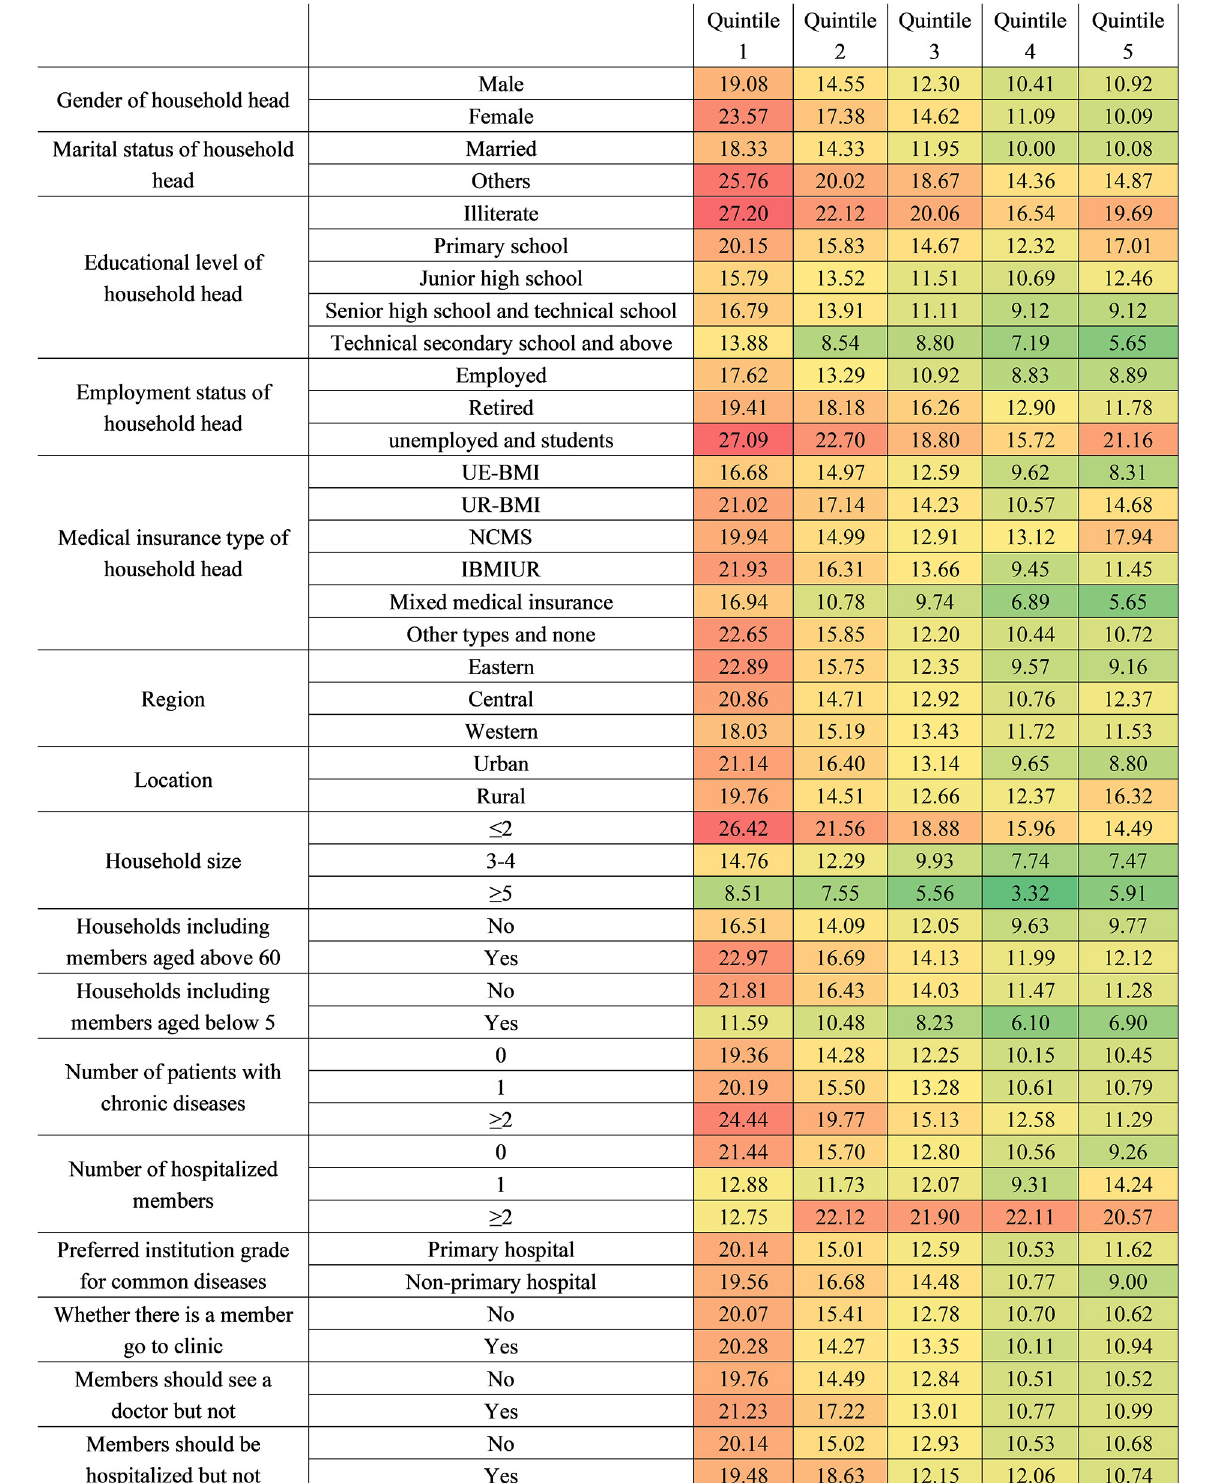
Frontiers in Public Health |